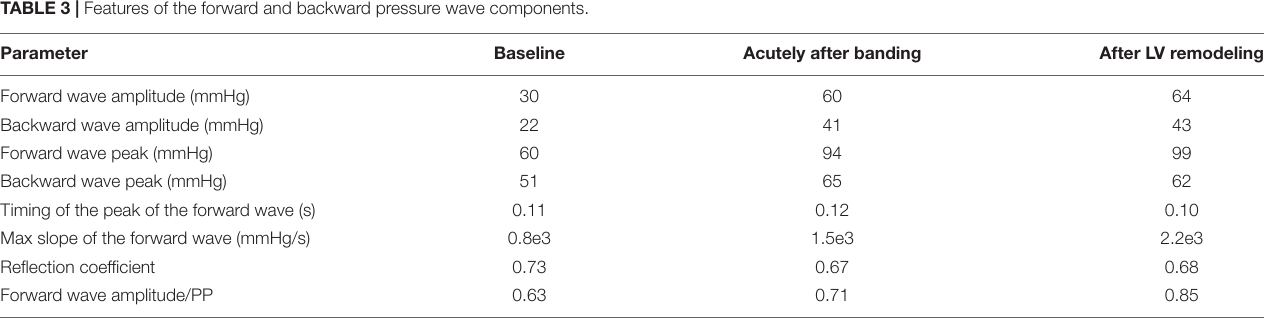
FIGURE 5 | Analysis of the pressure wave into its forward (continuous line) and backward component (dashed line) for the three generated hemodynamic states. TABLE 3 | Features of the forward and backward pressure wave